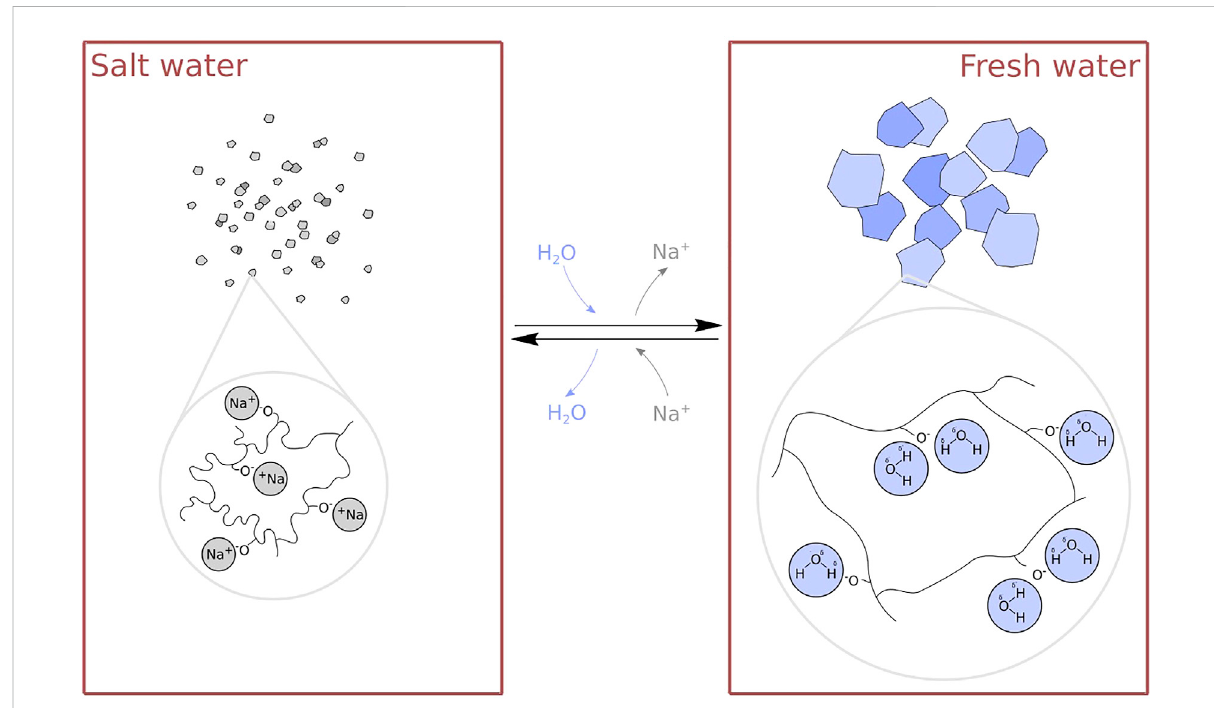
FIGURE 1 Thestructureandswellingbehaviour ofsodiumpolyacrylate.Insaltwater,sodium ions (Na + )interferewith water(H 2 O)uptakeandsigni fi cantly reduce the swelling of the gel (left). In salt-free environments, sodium ions diffuse out of the gel, which is then capable of holding a large amount of water (right).